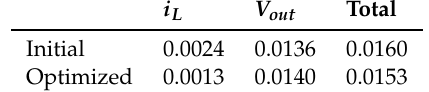
Table 8. ITAE values under the 150 [ Ω ] load test.